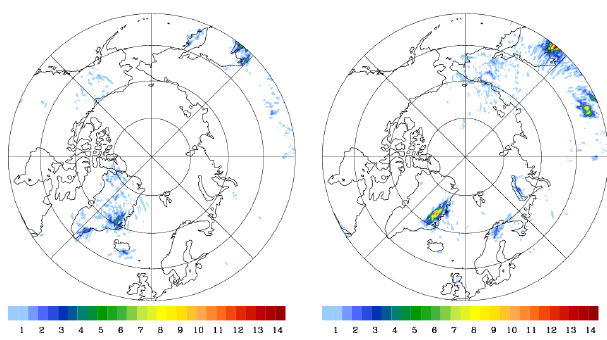
Fig. 15. Stratospheric gravity waves: locations of moun- tain wave occurrence (number of six-hourly events) as indi- Figure 15: Stratospheric gravity waves: Locations of mountain wave occurrence (number of 4 cated by regions of | DIV | > 2 × 10 − 4 s − 1 at 30hPa for Octo- six-hourly events) as indicated by regions of │ DIV │ > 2·10 -4 s -1 at 30 hPa for Oct/Nov/Dec 5 ber/November/December 2009 (left panel) and for January 2010 2009 (left panel) and for Jan 2010 (right panel). Operational ECMWF analyses interpolated at 6 (right panel). Operational ECMWF analyses interpolated at a regu- a regular 0.5 ° x 0.5 ° latitude/longitude grid. 7 lar 0 . 5 × 0 . 5 ◦ latitude/longitude